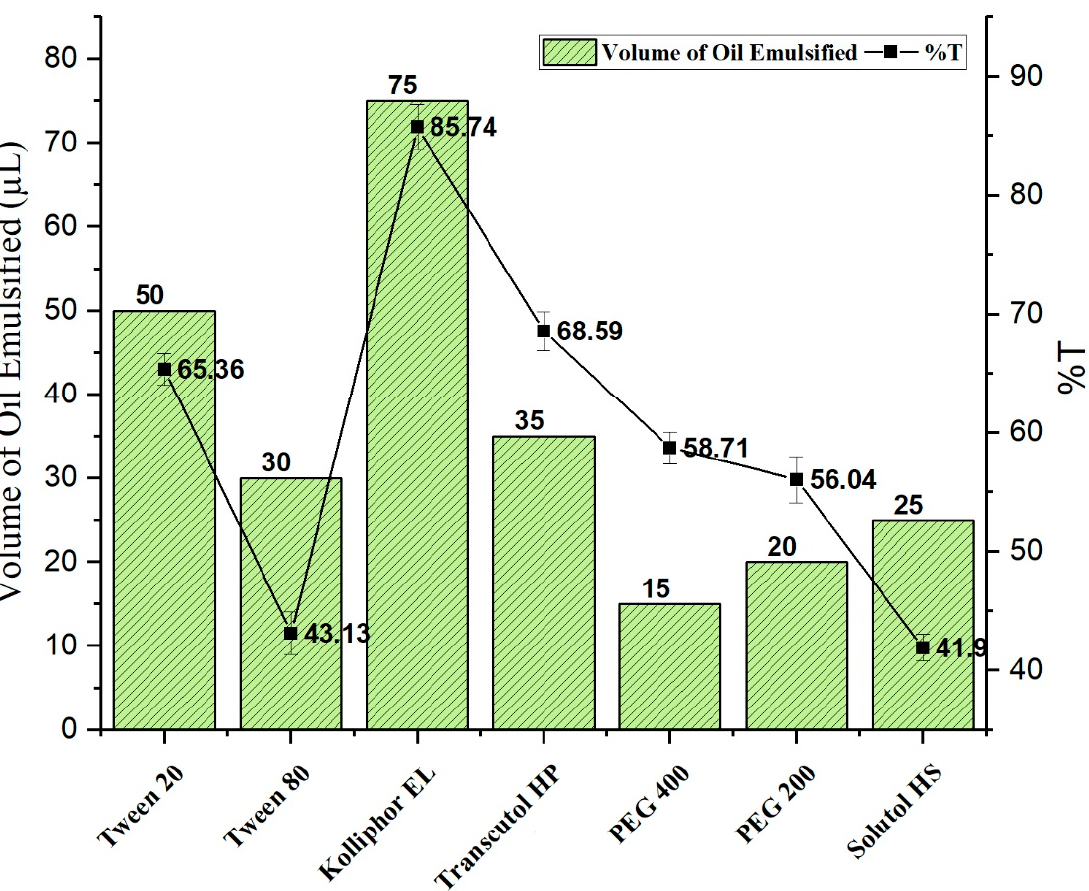
Figure 1. Emulsification efficiency of different surfactant and co-surfactant.